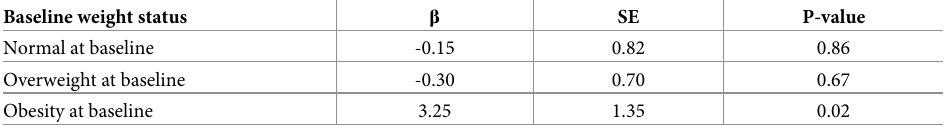
Table 3. Results of regression analyses examined the relationship between CSDs price discount frequency and women’s weights, stratified by baseline weight status � , n =